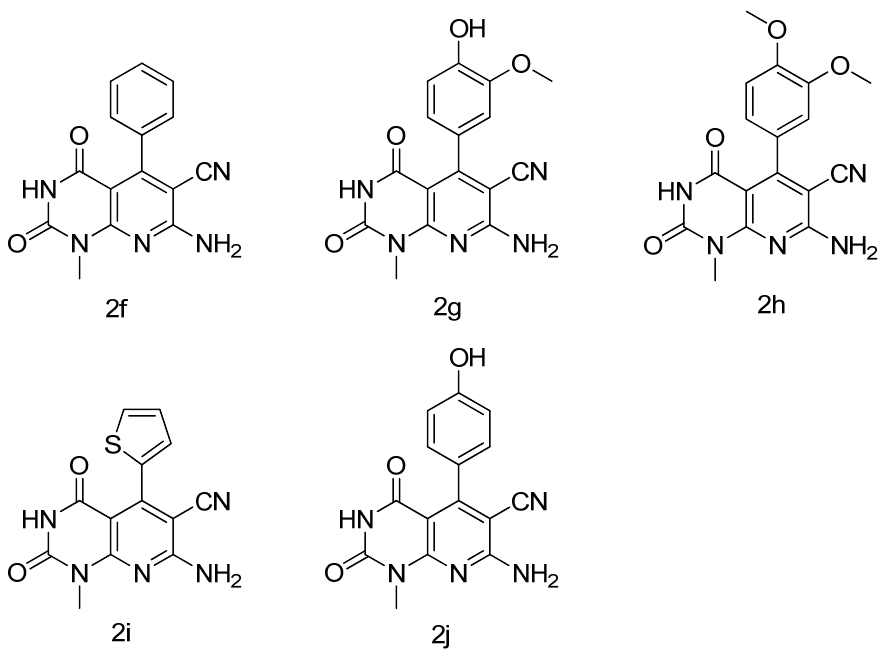
Figure 4. The chemical structure of compounds 2f–j